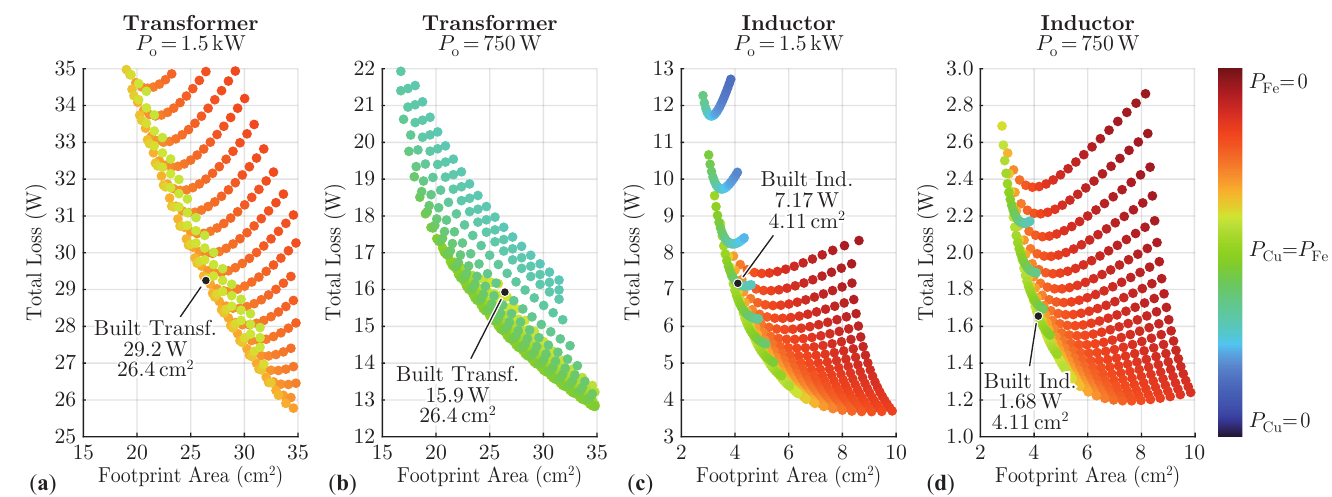
Figure 9. Pareto optimizations between total loss—sum of copper ( P Cu ) and core ( P Fe ) losses—and footprint area (directly related to volume) of the PCB-integrated ( a , b ) transformer and ( c , d ) inductor for ( a , c ) nominal and ( b , d ) 50% load. The design spaces were defined by sweeping core radius and winding width values for each of the two components to trade off the winding and core area. Selected designs that were Pareto-optimized for nominal load ( P o = 1.5kW) are shown as black dots, with the design characteristics of Table 4. Note that the Pareto-optimal designs are constant between full and 50% load for the inductor but change significantly for the